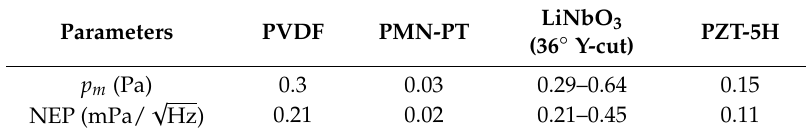
Table 2. The noise equivalent pressure (NEP) and p m values of thickness extension mode pMUTs based on di ff erent piezoelectric materials (5 MHz center frequency, 2 MHz